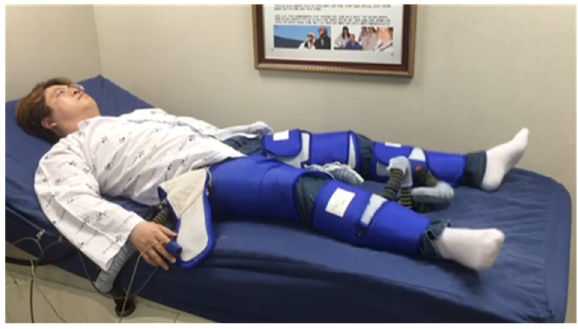
Figure 1. Pneumatic EECP therapy